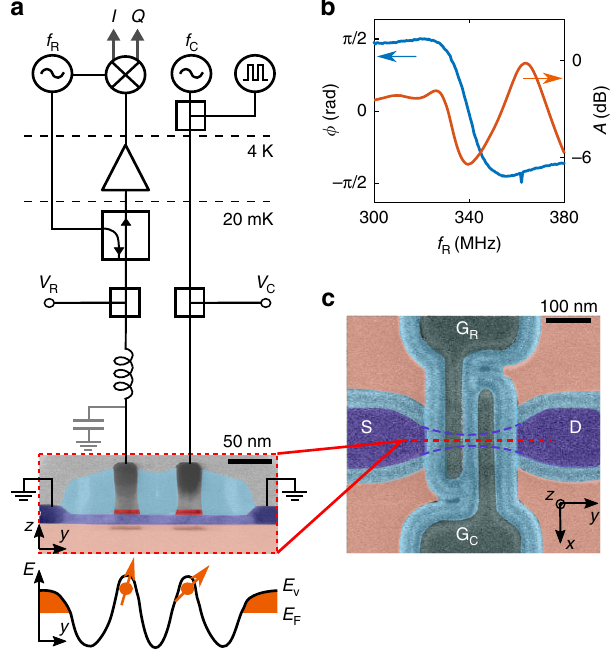
Fig. 1 Device layout and circuitry for qubit dispersive sensing and manipulation. a False-color transmission electron micrograph of a double- gate Si device. The 11-nm-thick, 35-nm-wide Si nanowire (light blue) connects p-type, boron-doped source-drain contacts (dark blue) and lies on a 140-nm-thick SiO 2 buffer layer (pink). The two 35-nm-wide gates (grey) are spaced by 35 nm. Si 3 N 4 spacers (cyan) prevent dopant implantation in the Si channel. At 20 mK, proper gate voltages induce the accumulation of two hole quantum dots: one can be used as a spin qubit, the other as a helper dot for qubit readout. One gate is connected to a lumped-element resonator excited at frequency f R for dispersive readout. A ultra-high frequency digital lock-in demodulates the re fl ected signal after a directional coupler, separating the incoming and outgoing waves, and a low-noise ampli fi er at 4 K. The other gate applies square pulses and GHz radiation to drive controlled coherent rotations of the hole spin qubit. At the bottom, DQD energy diagram with E v as valence band edge and E F as Fermi energy. b Phase response ( ϕ ) and attenuation ( A ) of the resonator at base temperature. c Scanning electron micrograph of the